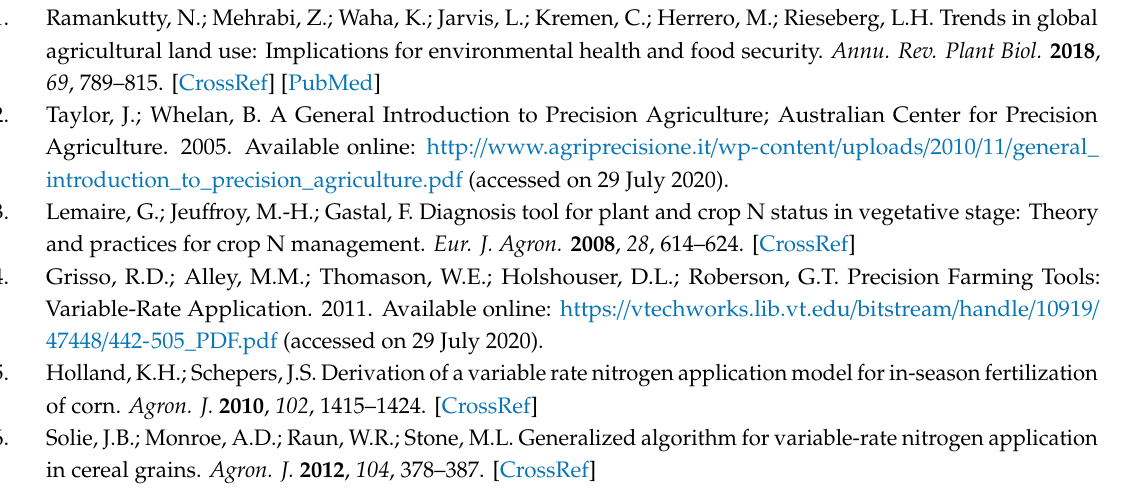
Figure S1: Minimum ( a ) and maximum ( b ) daily temperature of seasons 2015 and 2016 compared with climatology of the period (years 1993–2016). Mean values (m), mean plus one standard deviation (m + 1SD), mean plus two standard deviations (m + 2SD), mean minus one standard deviation (m − 1SD), mean minus two standard deviations (m-2SD) are shown. Figure S2: Monthly precipitation of seasons 2015 and 2016 compared with climatology of the period (years 1993–2016). Figure S3: Trial plots in the field situated in three zones identified through the visually inspection of Google RGB images (low, medium, and high crop vigor) and the preliminary analysis of soil ECa map (low, medium, and high). Zone 1 was characterized by low ECa and vigor, zone 2 by medium ECa and vigor, and zone 3 by high ECa and vigor. Figure S4: ECa map (mS m − 1) acquired at 15 kHz frequency. Figure S5: Mean aboveground biomass values from the plot experiment presented separately by time of monitoring survey, by nitrogen level (N0 = 0 kg N ha − 1 ; N72 = 0 kg N ha − 1 ; N144 = 144 kg N ha − 1 ) and by field zone (1, 2, and 3 representative of low, medium, and high grain yield, respectively). Error bars represent the standard error of the mean. Table S1: Characterization of the clusters indicating for each cluster: the categorical variables (development stage, DVS: early tillering “eTl”, stem elongation “StEl”, late booting “lB”; the yield-based MZs corresponding to the yield levels 1 “low”, 2 “medium”, and 3 “high”); the percentage of pixels for each category of the categorical variables (Cla / Mod); the percentage of pixels classified with the indicated categorical variable (Mod / Cad); the percentage of pixels of all dataset classified with the indicated categorical variable (Global), the p -value (P) of the student t test used to compare the average of the category with the general average; v.test (the transformation of P into a normal quantile). Categories are ordered by v.test values. Table S2: v.test results for each cluster. The mean and the standard deviation values for each “original variable” used for PCA analysis (“Mean in category” and “SD in category”) are reported. Overall mean and standard deviation are also reported. Table S3: Results of the split-plot ANOVA for wheat above ground biomass at harvest (t dry matter ha − 1 ), separately for each field survey. Significance of the di ff erences between zones, the linear and quadratic trends of above ground biomass to N fertilizer, and their interactions are also reported. Table S4: Results of the split-plot ANOVA for wheat N uptake at harvest (kg N ha − 1 ), separately for each field survey. Significance of the di ff erences between zones, the linear and quadratic trends of N uptake to N fertilizer, and their interactions are also